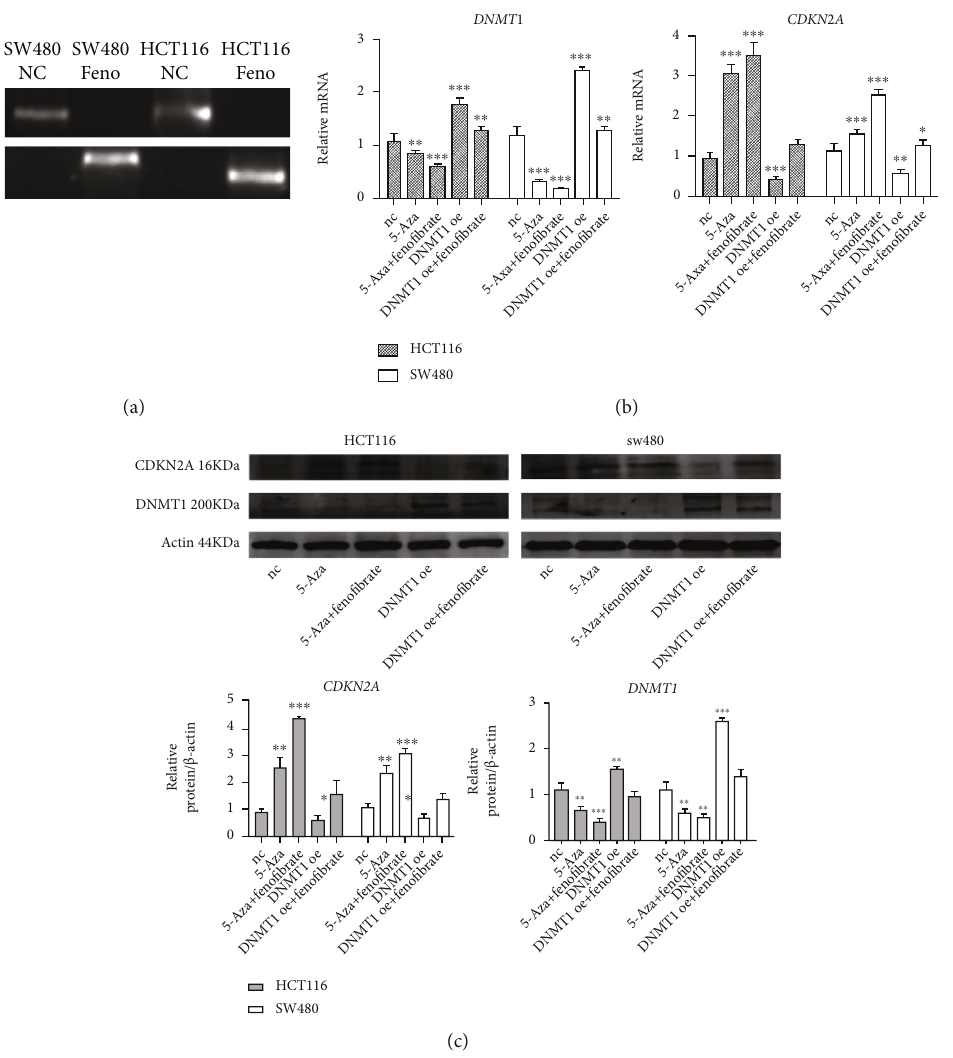
Figure 6: DNMT1 repressed CDKN2A expression by promoter hypermethylation. (a) MSP results showed the methylation status of CDKN2A following feno fi brate treatment. (M: reactions using CDKN2A primers speci fi c for methylated CpG sites; U: reactions using CDKN2A primers speci fi c for unmethylated CpG sites). (b) The mRNA expression of DNMT1 and CDKN2A in cells was measured using qRT-PCR. Data was presented as mean ± SD (NC: untreated cell; 5-Aza: 5-azacytidine treated cell; DNMT1 oe: DNMT1 overexpression cell; ∗ P < 0 : 05 , ∗∗ P < 0 : 01 , ∗∗∗ P < 0 : 001 ). (c) The protein expression of CDKN2A and DNMT1 in SW480 and HCT116 cells was measured using western